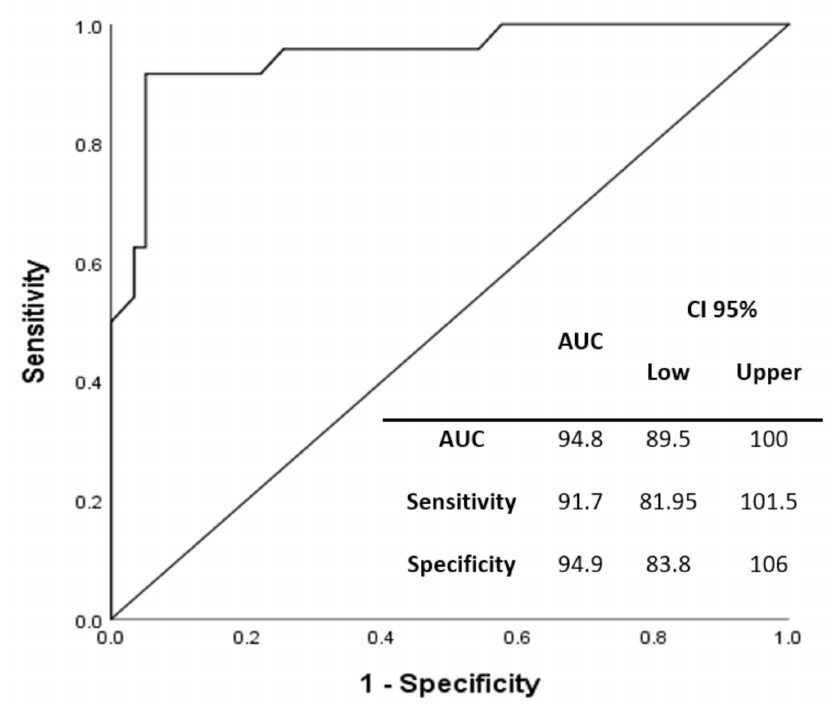
Figure 3. Internal validation using the AUC (area under the ROC curve). CI—confidence